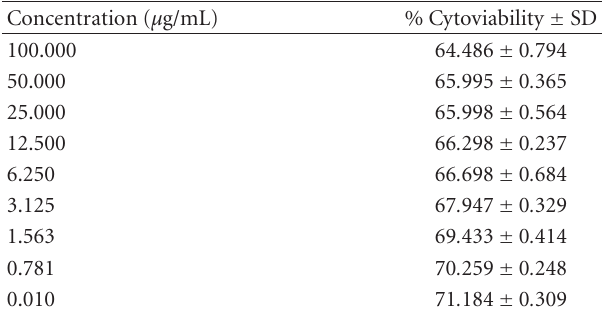
Table 1: Percentage of cytoviability of human gingival fibroblasts treated by Cricula triphenestrata cocoon extract.